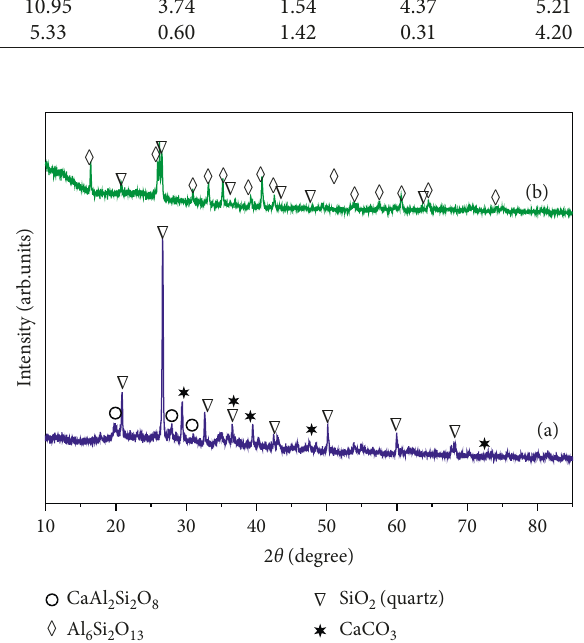
Figure 2: X-ray diffraction patterns of (a) sewage sludge and (b) fly ash.